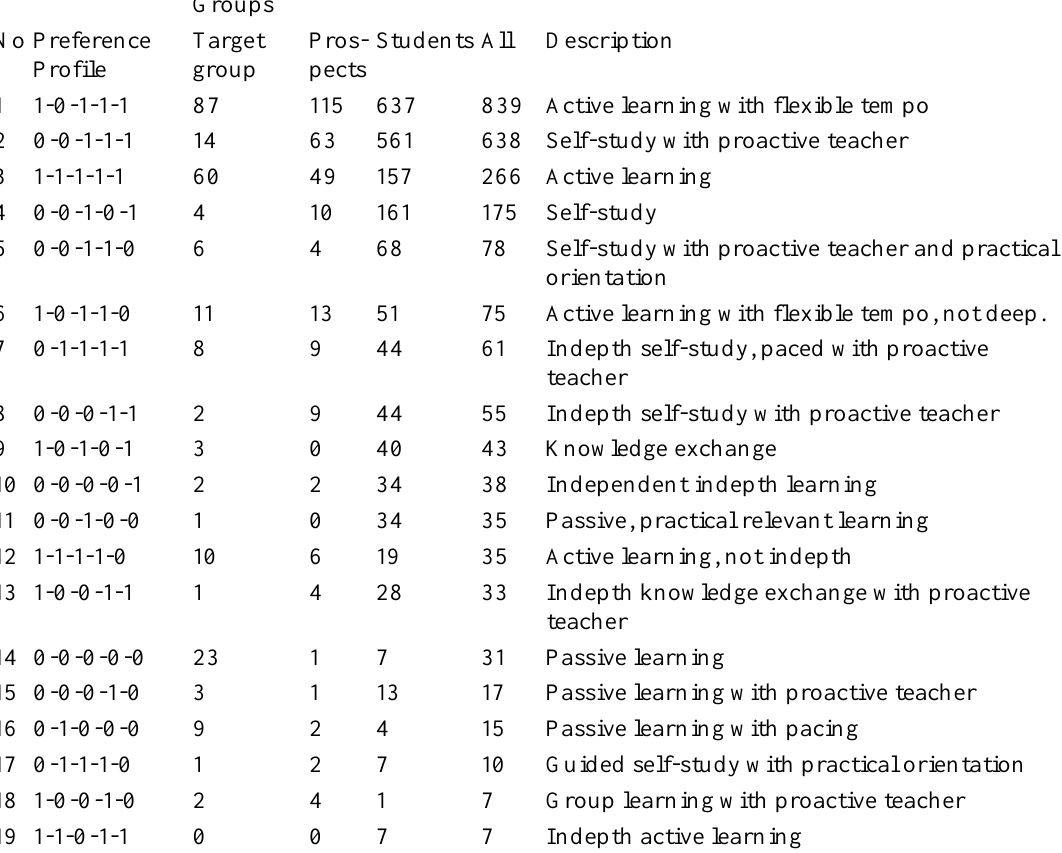
Preference Profiles per Group, Sorted on Frequency for All Participants with Description of each